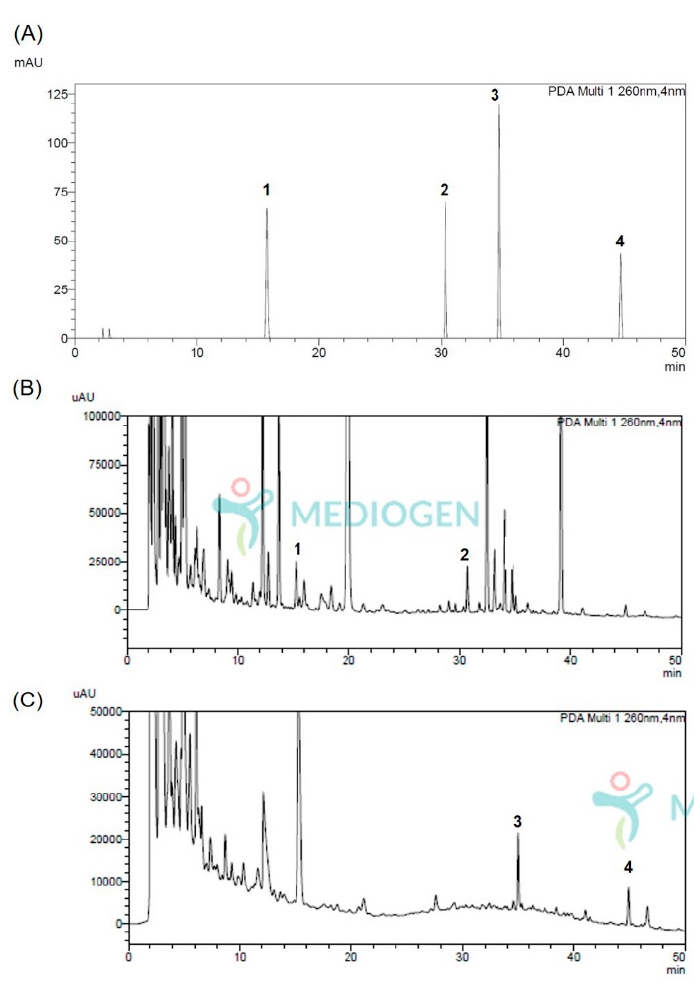
Figure 1. The chromatograms of ( A ) standards (20 ppm, each), ( B ) NF-AM (50 mg/mL), and ( C ) MG5276F-AM (50 mg/mL) by HPLC analysis. 1, calycosin-7- O -glucoside; 2, formonetin-7- O -glucoside; 3, calycosin; 4, formononetin.